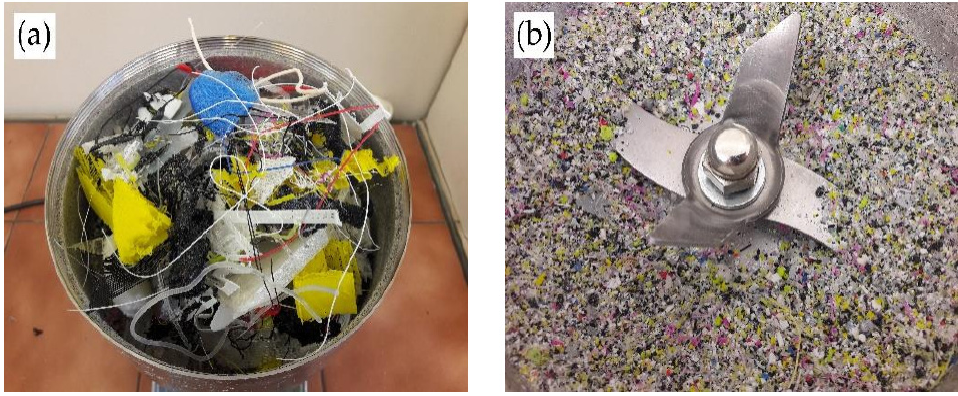
Figure 13. Appearance of PLA waste: ( a ) before grinding, ( b ) after